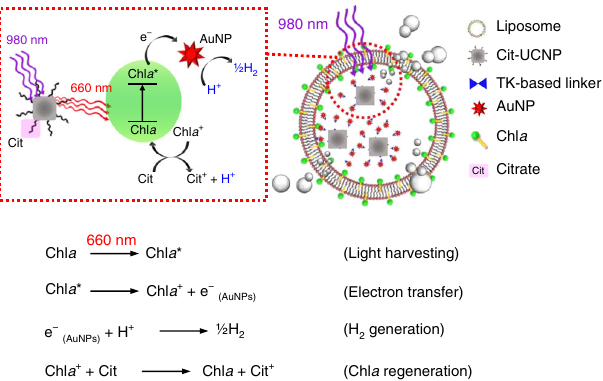
Fig. 2 Potential mechanism of photosynthesis of hydrogen. When red UCL at 660 nm is harvested by Chl a , the latter becomes excited (Chl a *). The photo-excited electrons are rapidly transferred to AuNPs, which can collect protons from citrate, resulting in hydrogen evolution. The oxidized Chl a can be reduced with acceptance of an electron from citrate, returning to its ground state.